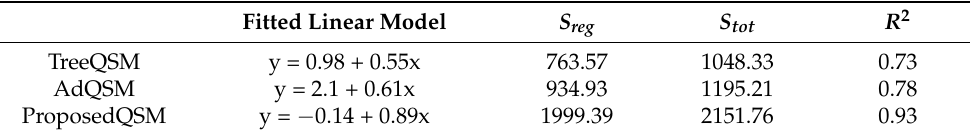
Figure 17. Regression analysis between the built QSM volume and harvested volume. ( a ) Regression analysis for TreeQSM; ( b ) regression analysis for AdQSM; ( c ) regression analysis for ProposedQSM. Table 4. Comparison of R 2 toward the three methods.